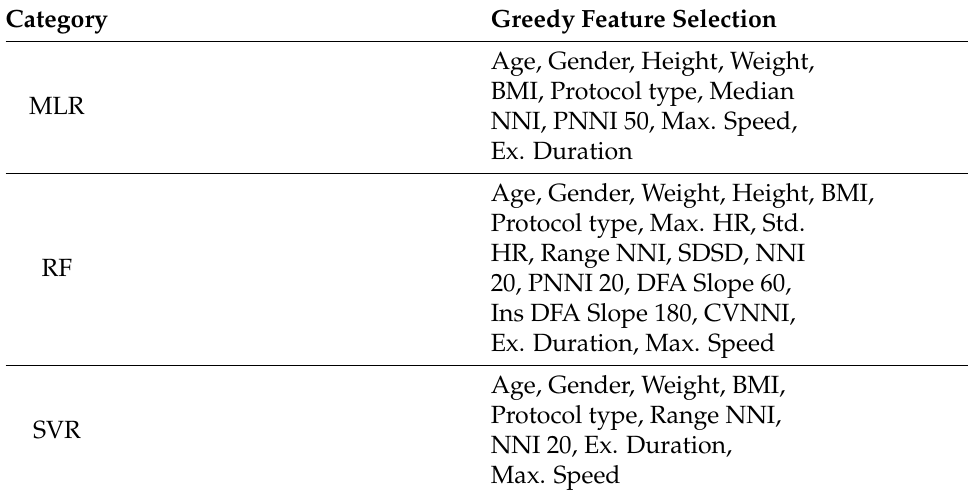
Table 3. Best features based on Greedy feature selection during